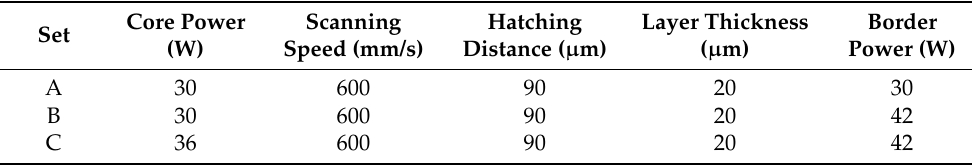
Table 1. Printing parameters used for the fabrication of tensile and impact specimens. The notions of “core” and “border” are illustrated in Figure